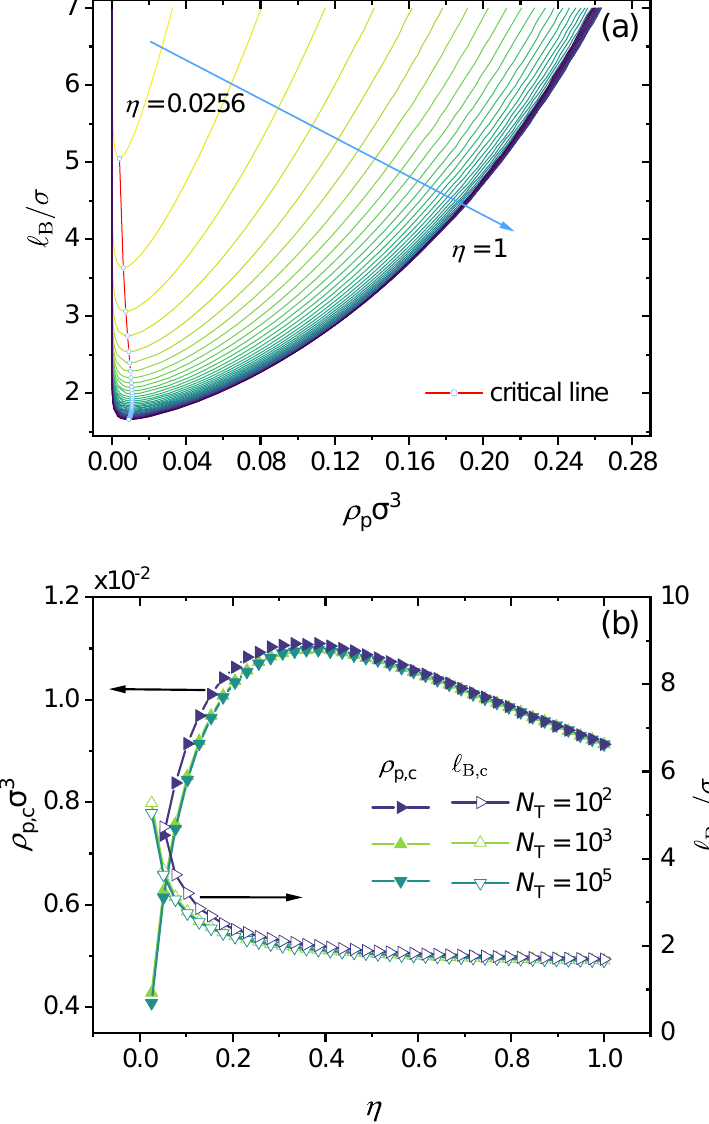
Figure 8. Effect of charge fraction: ( a ) Predicted binodal curves from the GUI App presented in this work. The values for the following parameters were fixed: (cid:101) AC = (cid:101) A = (cid:101) B = 0, Z A = − 1, Z C = + 2, N T = 10 5 , and N 1 = N T η − 1 (block copolymer). ( b ) Concentration of polymer ρ p,c (left y-axis) and Bjerrum length (cid:96) B,c (right y-axis) of critical points in the binodal curves versus η from 0 to 1 under different total lengths N T of polymer. The values of all parameters are the same as those used in ( a ) unless otherwise specified in the